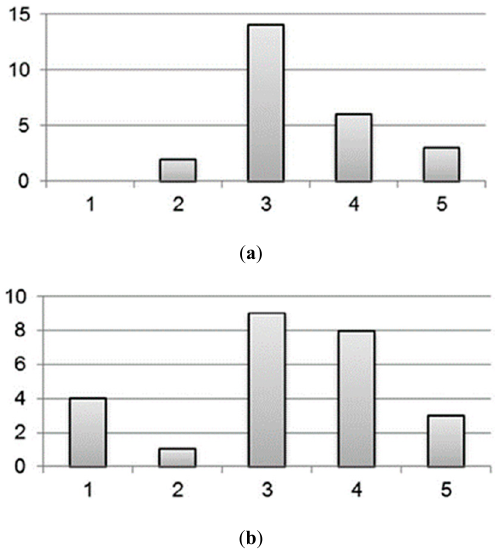
Figure 6. Results of the interview questions: ( a ) “Does the assistive device help you to perceive your environment better?” and ( b ) “Does the assistive device increase your confidence in independent walking?” The answers reported on the X-axes are: (1) not at all, (2) not much, (3) to some extent, (4) significantly, (5) very significantly [20].